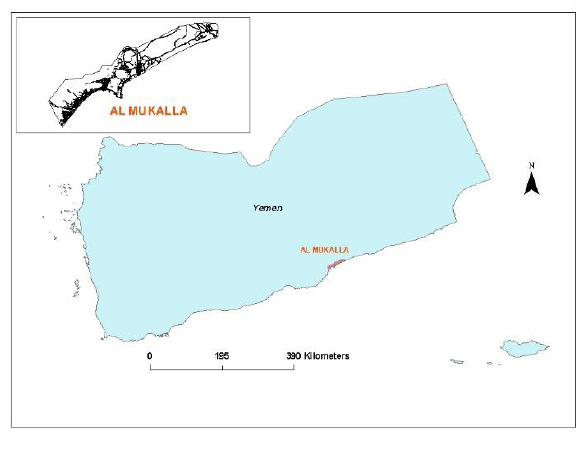
Figure 3. Location of the study